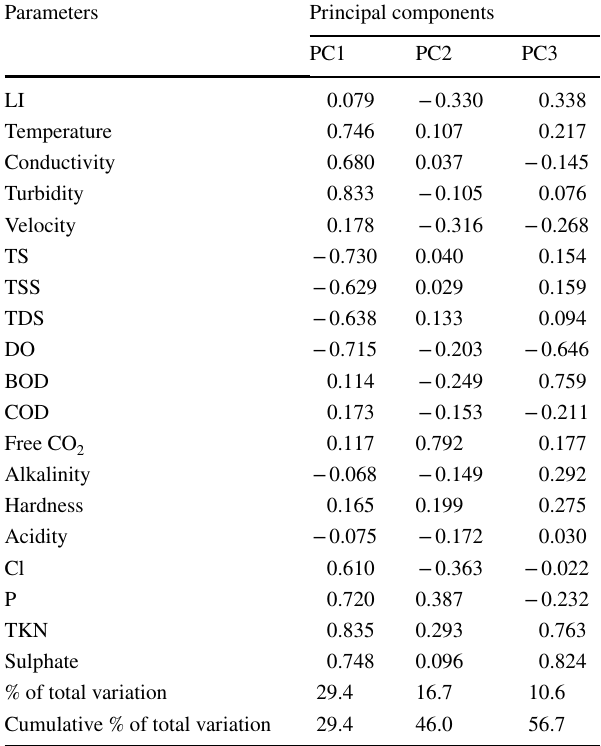
Table 4 Factor matrix obtained by the method of principal compo-